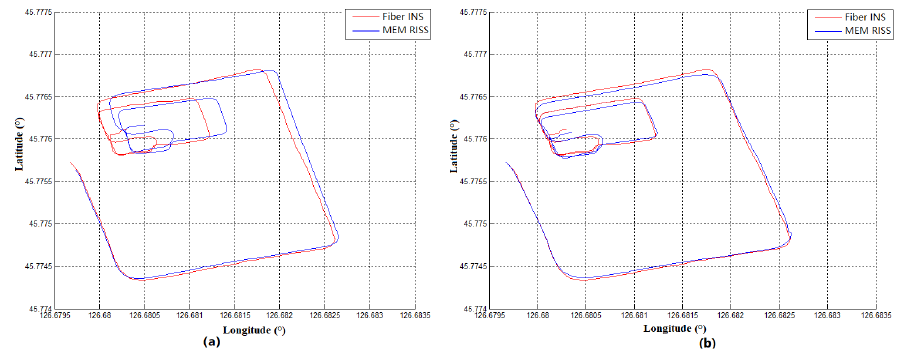
Figure 9. Fiber-INS MEMS-RISS trajectory comparison diagram. ( a ) Fiber-INS and RISS-DR trajectory diagram; ( b ) Fiber-INS and RISS-GPS trajectory diagram.